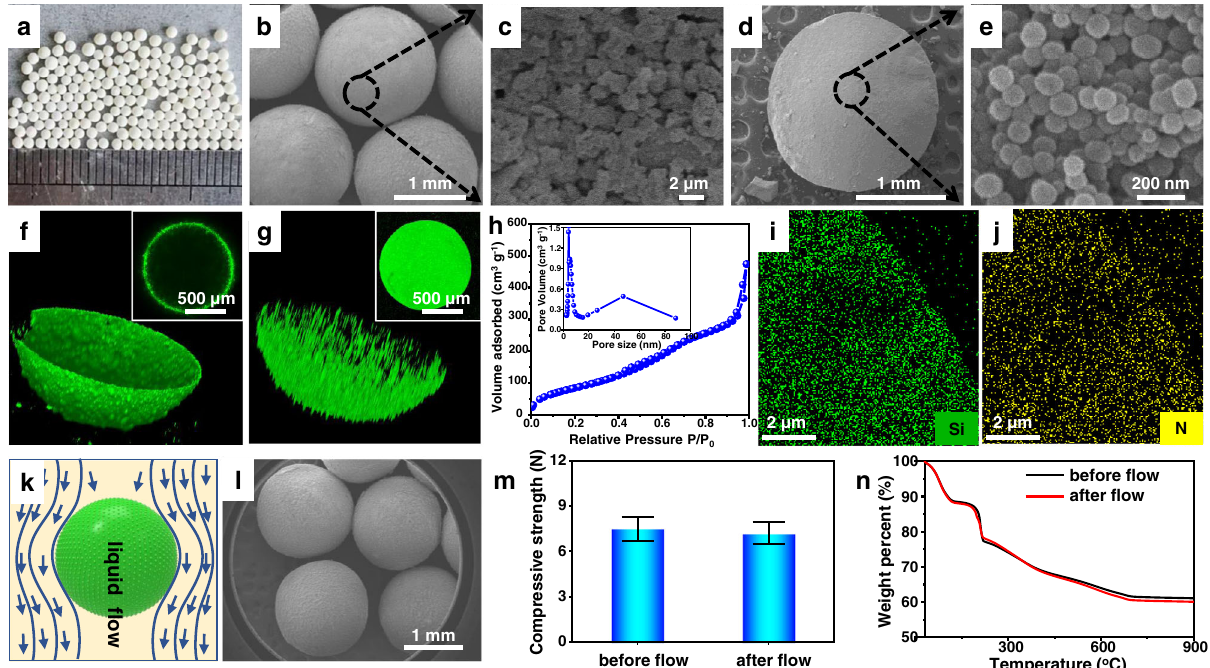
Fig. 2 | Structural characterization of SPs. a Appearance of SPs. b SEM image of SPs. c SEM image showing the surface of SPs. d SEM image showing the interior structure of SPs, after being cut deliberately. e Magni fi ed SEM image showing the interior structure of SPs. f Fluorescence confocal microscopy image of SPs with hydrophobized spongy silica powders labelled by FITC-I. g Fluorescence confocal microscopyimageofSPswithMSNslabelledbyFITC-I. h N 2 adsorption-desorption